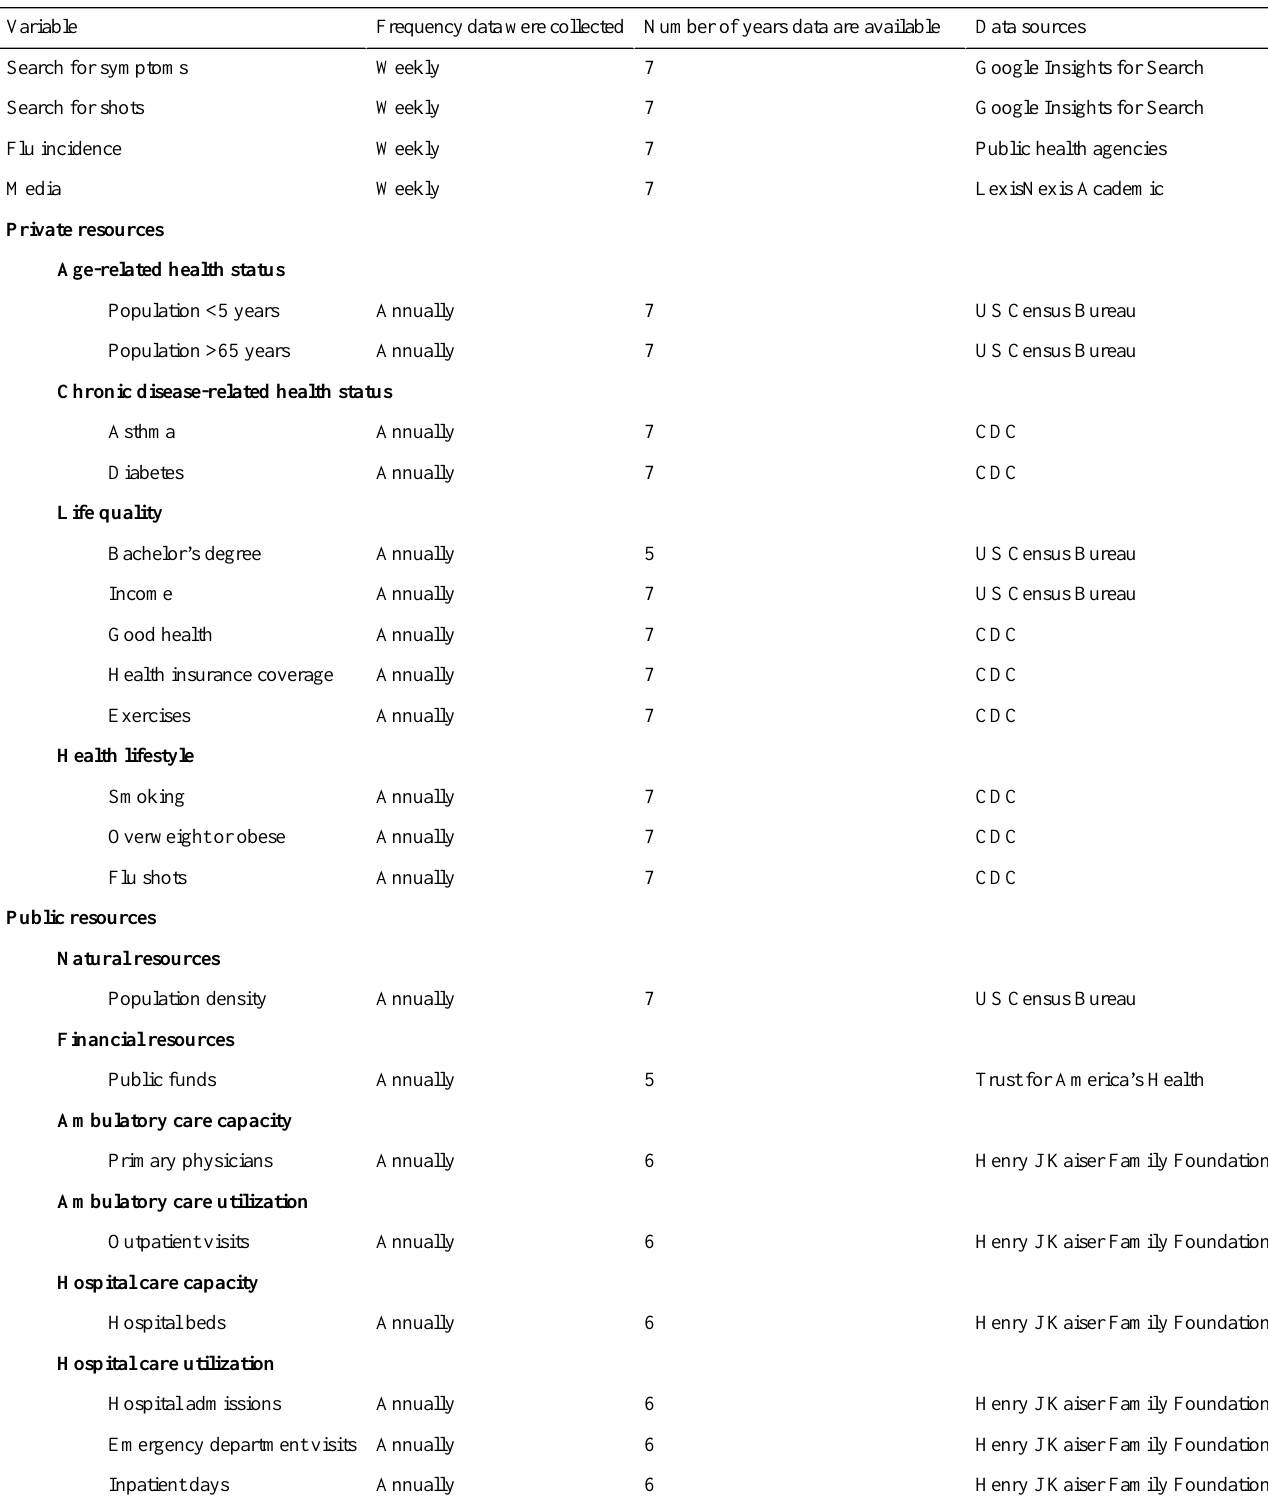
Table 2. Study variables: data availability and sources.